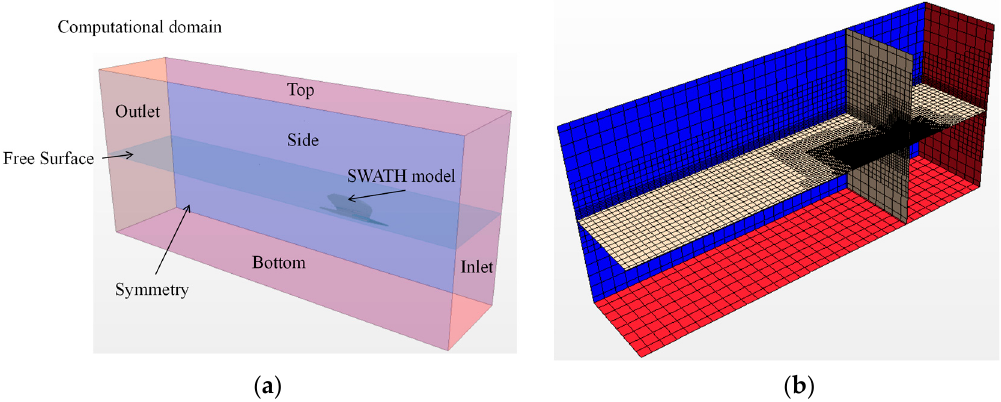
Figure 1. Computational domain and mesh: ( a ) Computational domain and boundaries; ( b ) Mesh for the domain.